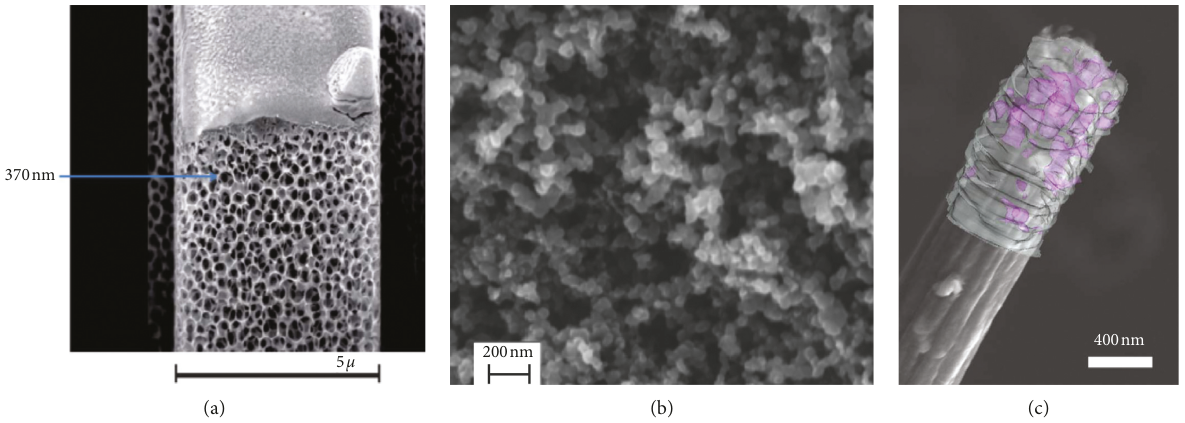
Figure 4: FIB-SEM images. (a) Cross-sectional SEM image of a SiO 2 nanoparticle [41], (b) SEM image of microstructure of porous carbon electrode [39], and (c) reconstructed FIB-SEM image applied onto the SEM of a single nanofiber